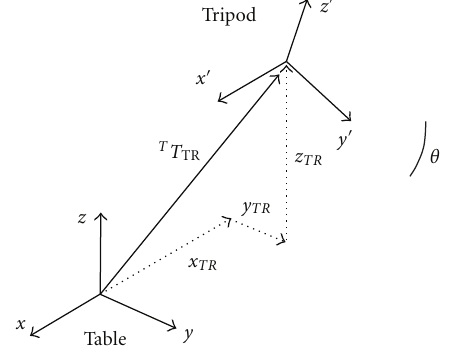
Figure 7: The coordinate system of the tripod machine tool.